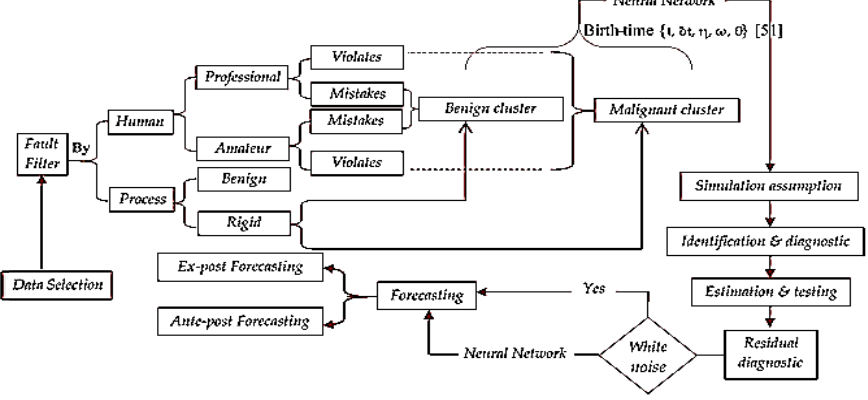
Figure 2. The conceptual classification of faults severity.